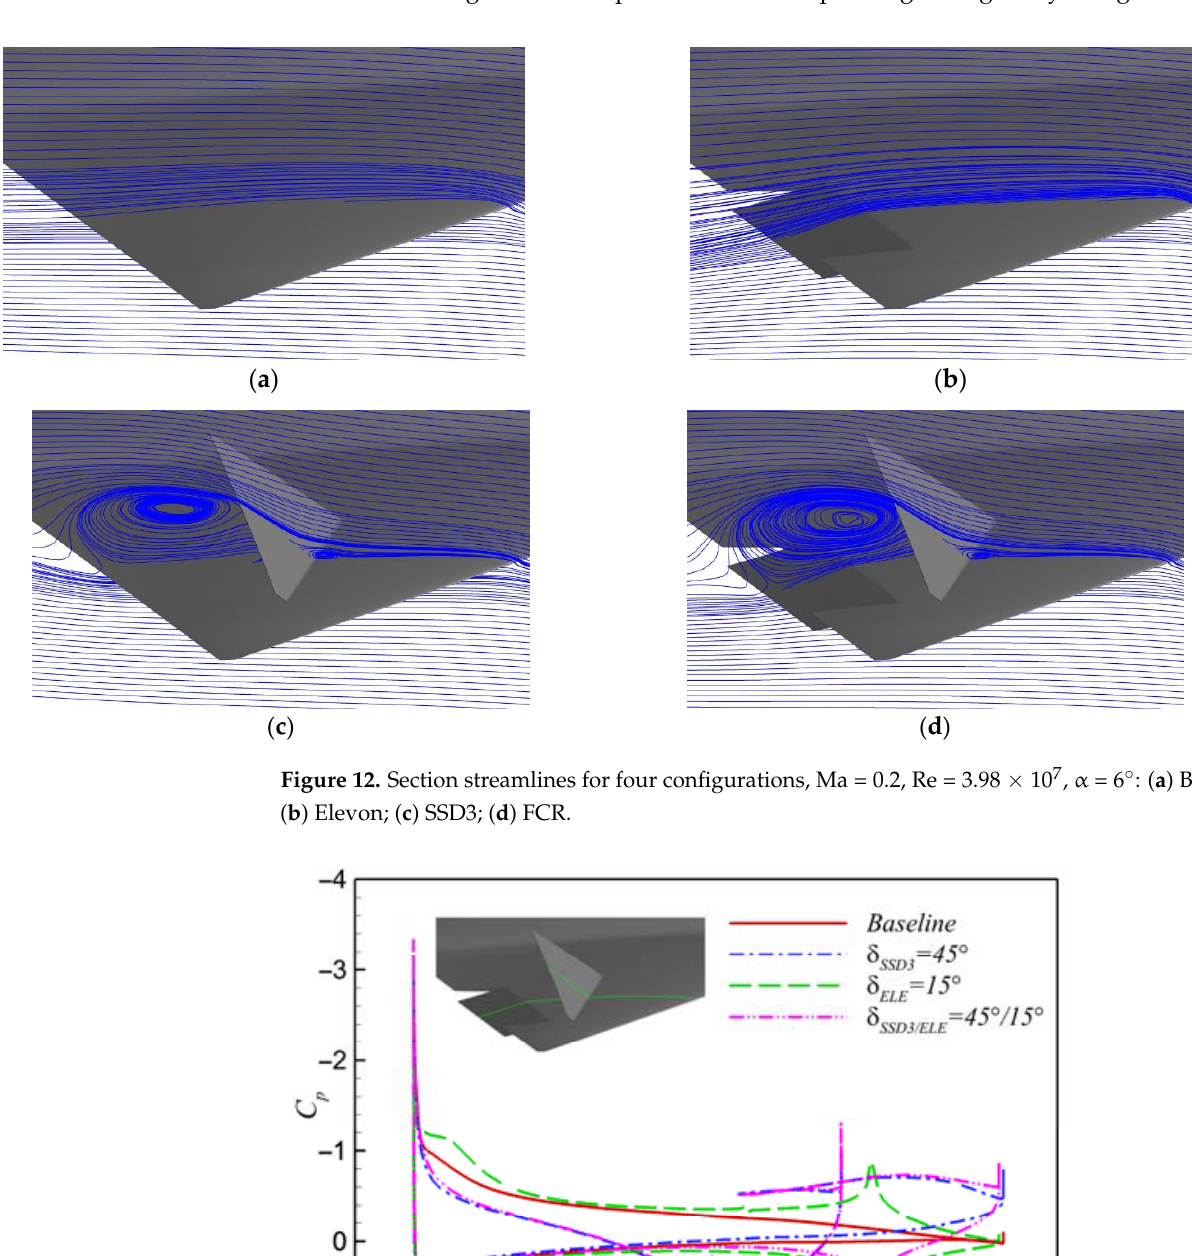
Figure 13. C p distribution for the sections of four configurations, Ma = 0.2, Re = 3.98 × 10 7 , α = 6°.